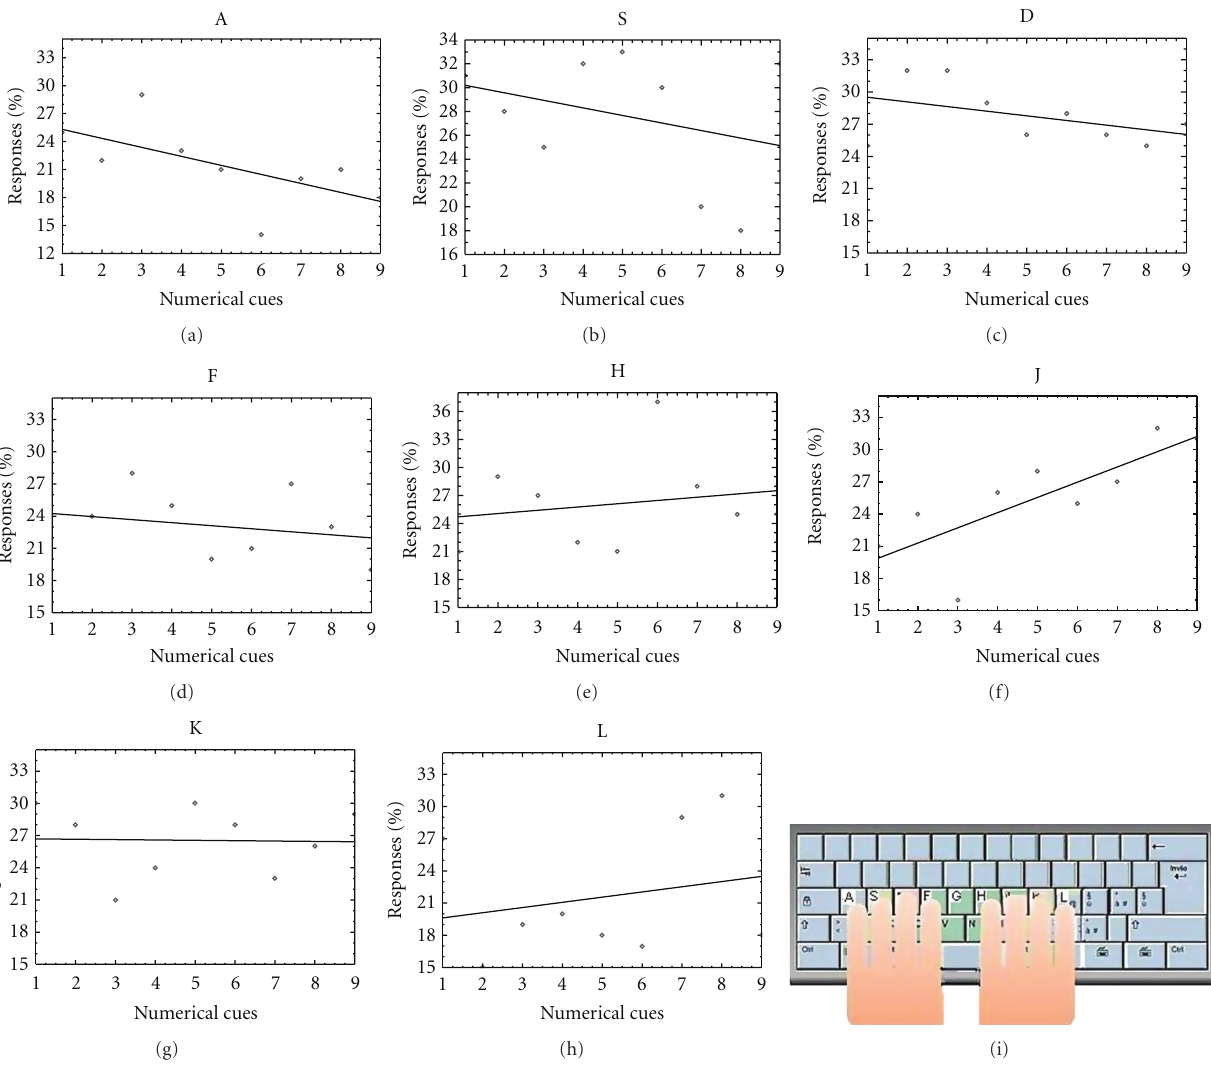
Figure 3: The figure plots the percentage average of finger movements for the eight keys of the keyboard during the exposure to the nine numerical cues at 300 msec of ISI. The ordinate represents the proportion of responses generated with a finger; the abscissa represents the displayed numerical